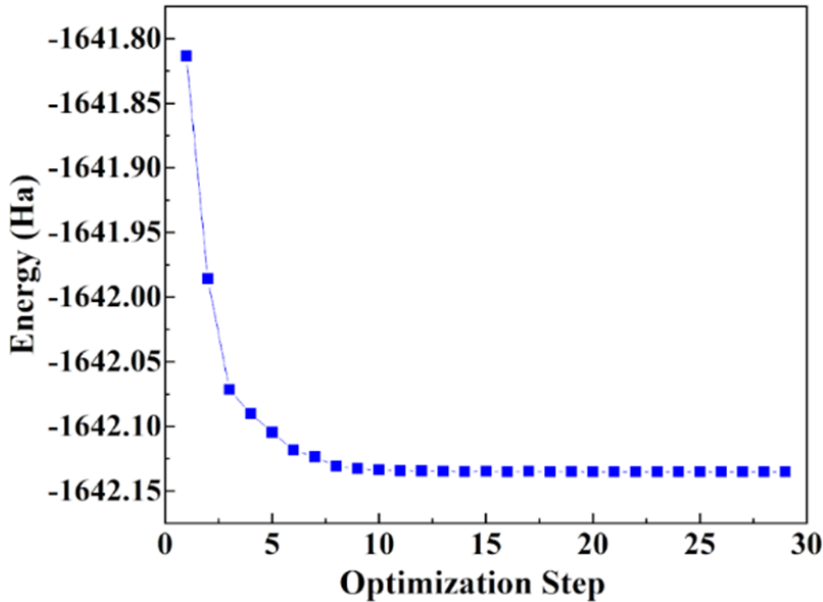
Figure 9. Energy change during optimization of MB molecular model.